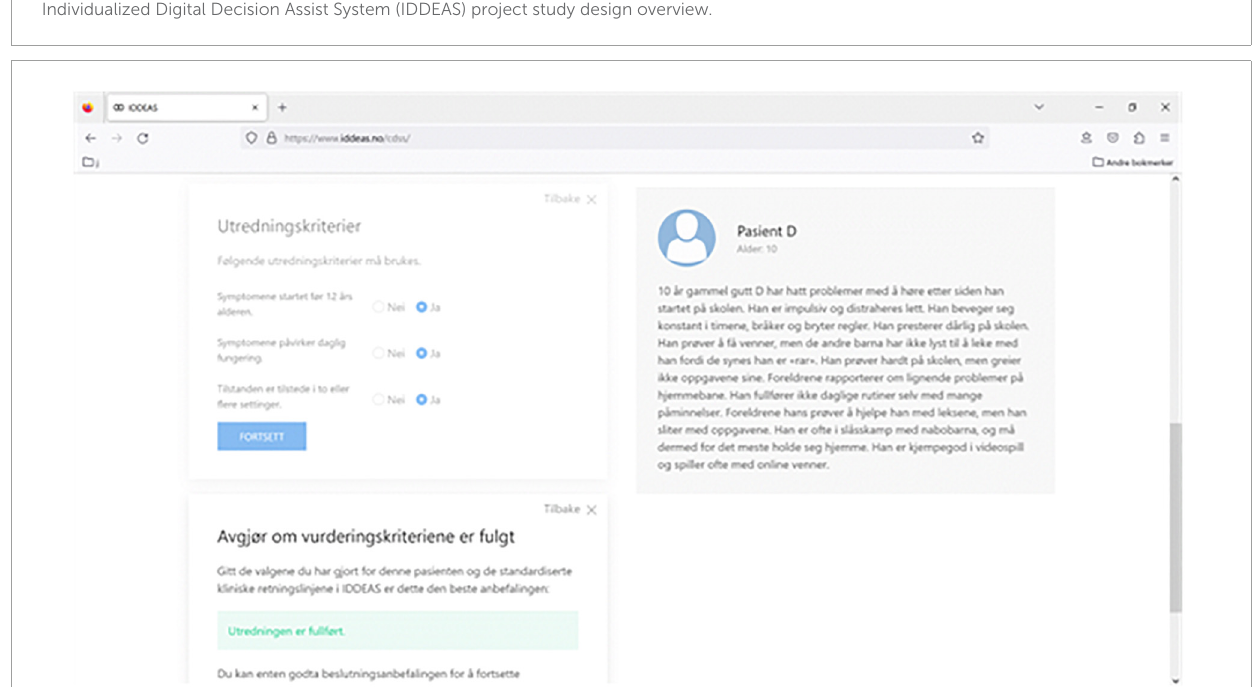
FIGURE2 Individualized Digital Decision Assist System prototype software